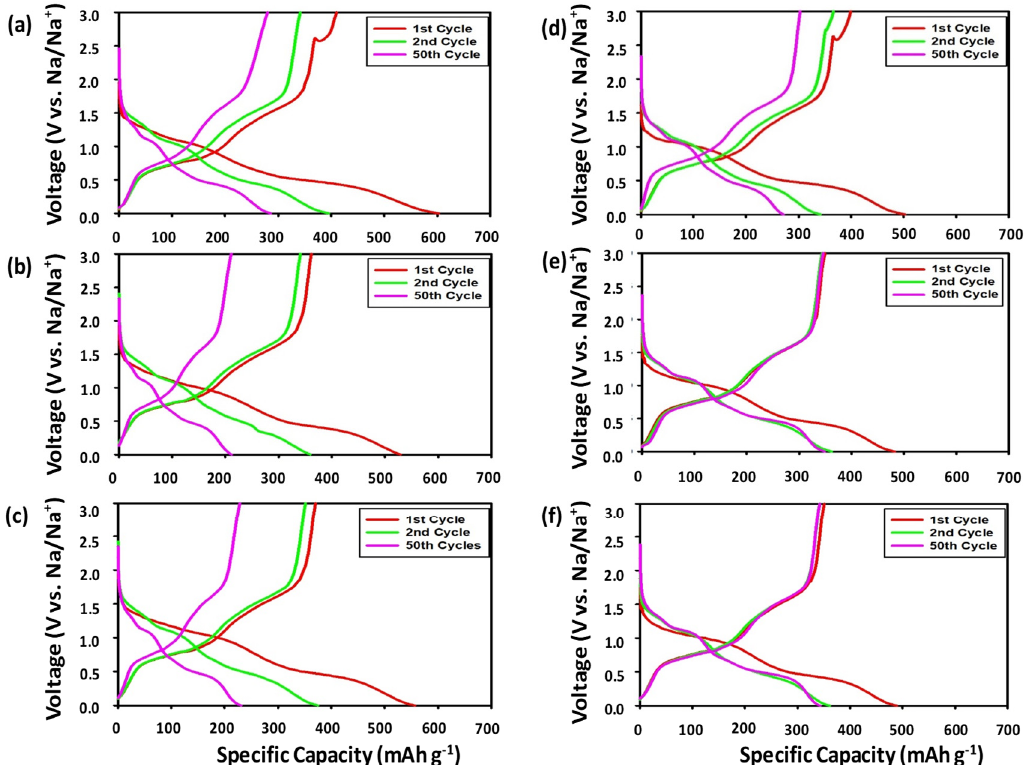
Figure 5. Voltage profiles of the SbTe-C40 electrode with ( a – c ) 0%, 2%, and 5% FEC (respectively) and the PVDF binder, and ( d – f ) 0%, 2%, and 5% FEC (respectively) and the PAA binder.